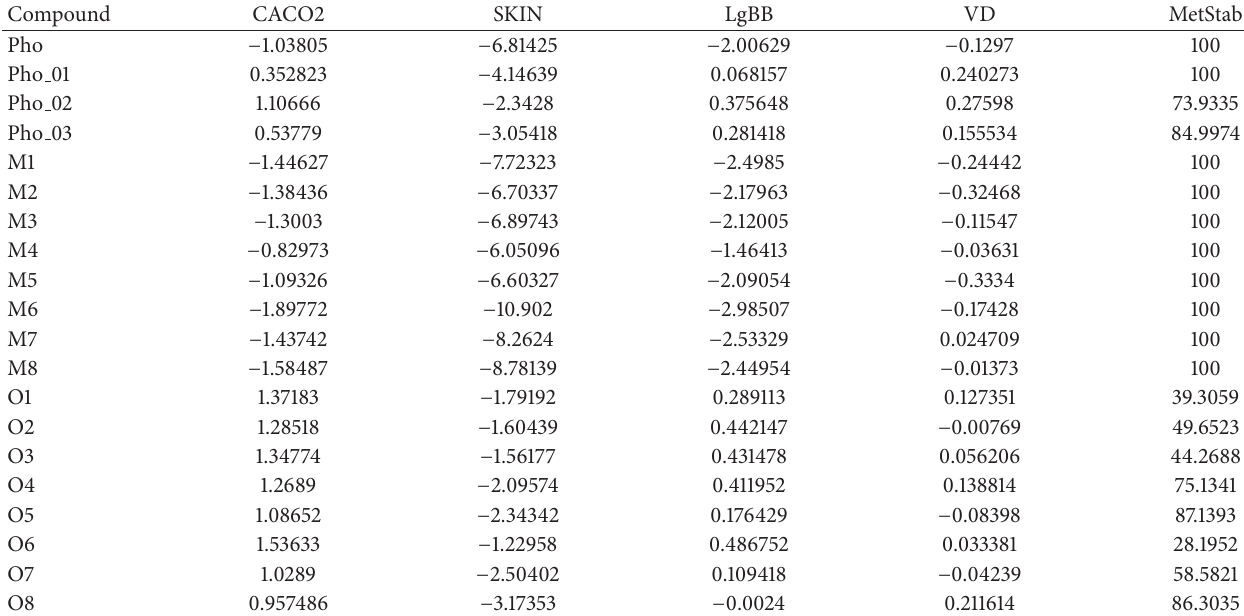
Table 4: VolSurf molecular descriptors appropriable to evaluate ADME process and drug behavior. CACO2 cells and SKIN permeability,